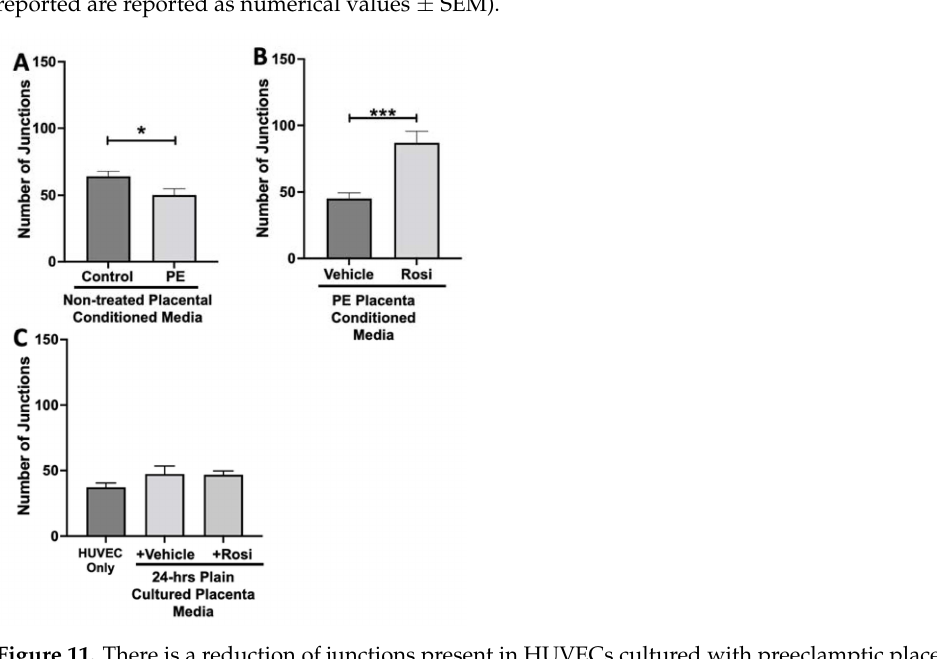
Figure 10. There is a significant reduction in the number of nodes present in the HUVECs cultured with preeclamptic conditioned media, but this is reversed in Rosiglitazone-treated placentas. HUVECs were cultured with conditioned media on matrigel, and the number of nodes present was calculated by the Image J Angiogenesis Analyzer tool (30). HUVECs cultured with conditioned media from preeclamptic (PE) placentas show significantly reduced number of nodes as compared to healthy control placentas ( A , n =6). Conditioned media from Rosiglitazone (Rosi)-treated PE placentas led to a significant increase in the number of nodes present in the HUVECs compared to the conditioned media from the vehicle-treated PE placentas ( B , n = 6). Rosi and vehicle were cultured in placental media without any tissues for 24 h then applied to the HUVECs. Additionally, HUVECs cultured with standard full-serum media (HUVEC Only) all served as controls for this experiment. There were no significant changes in the number of nodes present among the HUVEC Only, Rosi, and vehicle conditioned media controls ( C , n = 6). (Statistical analysis was performed by student’s t -test to determine significant differences between groups, ** p < 0.01, *** p < 0.001, bar plots and data reported are reported as numerical values ± SEM).